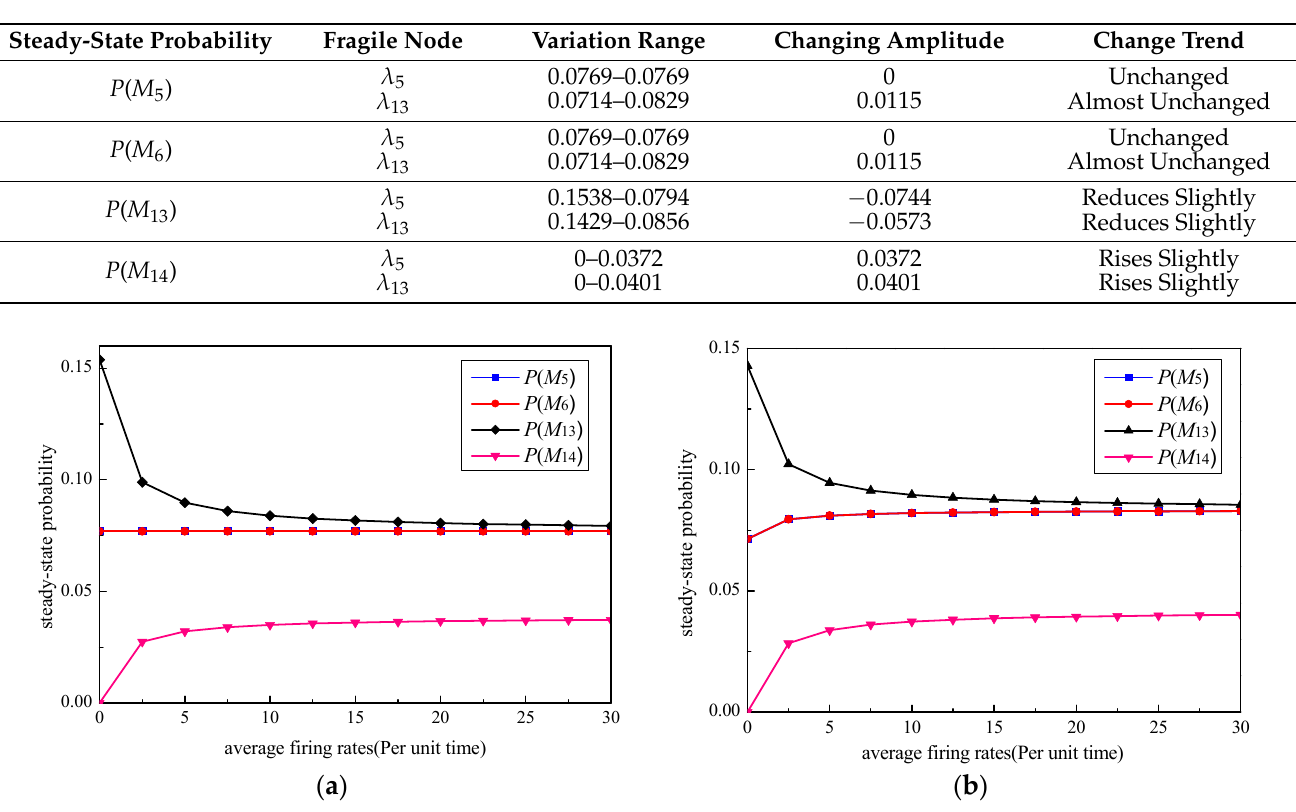
Table 5. Changes in the steady-state probability of each end state when and changes.